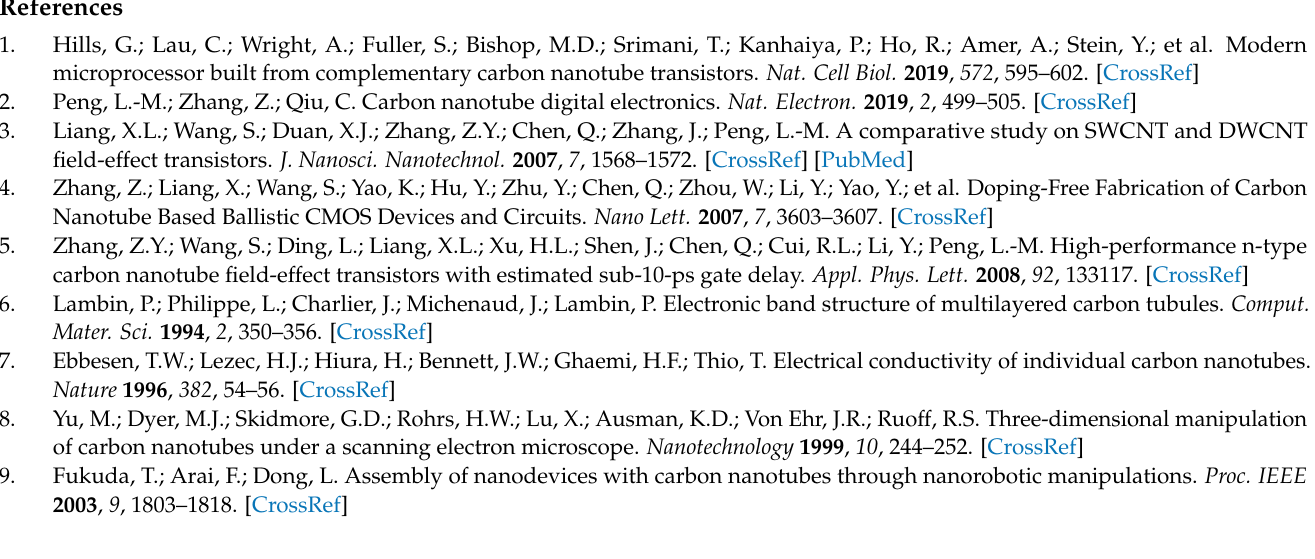
curve; Figure S4. Tungsten probe contacting with MWCNT bundle and the current voltage curve; Figure S5. Pt-coated Tungsten probe contacting with MWCNT bundle and the current voltage curve; Figure S6. Pt-coated tungsten probe contacting with MWCNT bundle and the current voltage curve; Figure S7. Pt-coated tungsten probe-MWCNT bundle-AFM cantilever and the current voltage curve; Figure S8. Pt-coated tungsten probe-MWCNT bundle-tungsten probe and the current voltage curve; Figure S9. Tungsten probe- MWCNT bundle- AFM cantilever and the current voltage